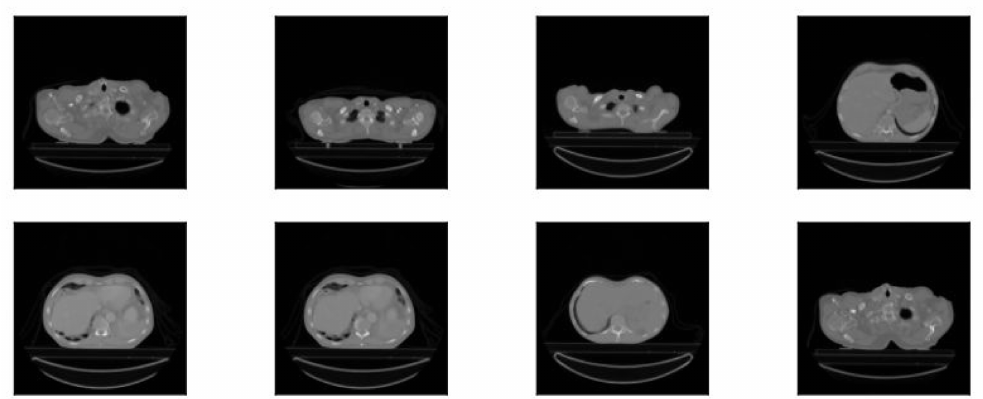
Figure 4. Example of images classified as false negative by all tested